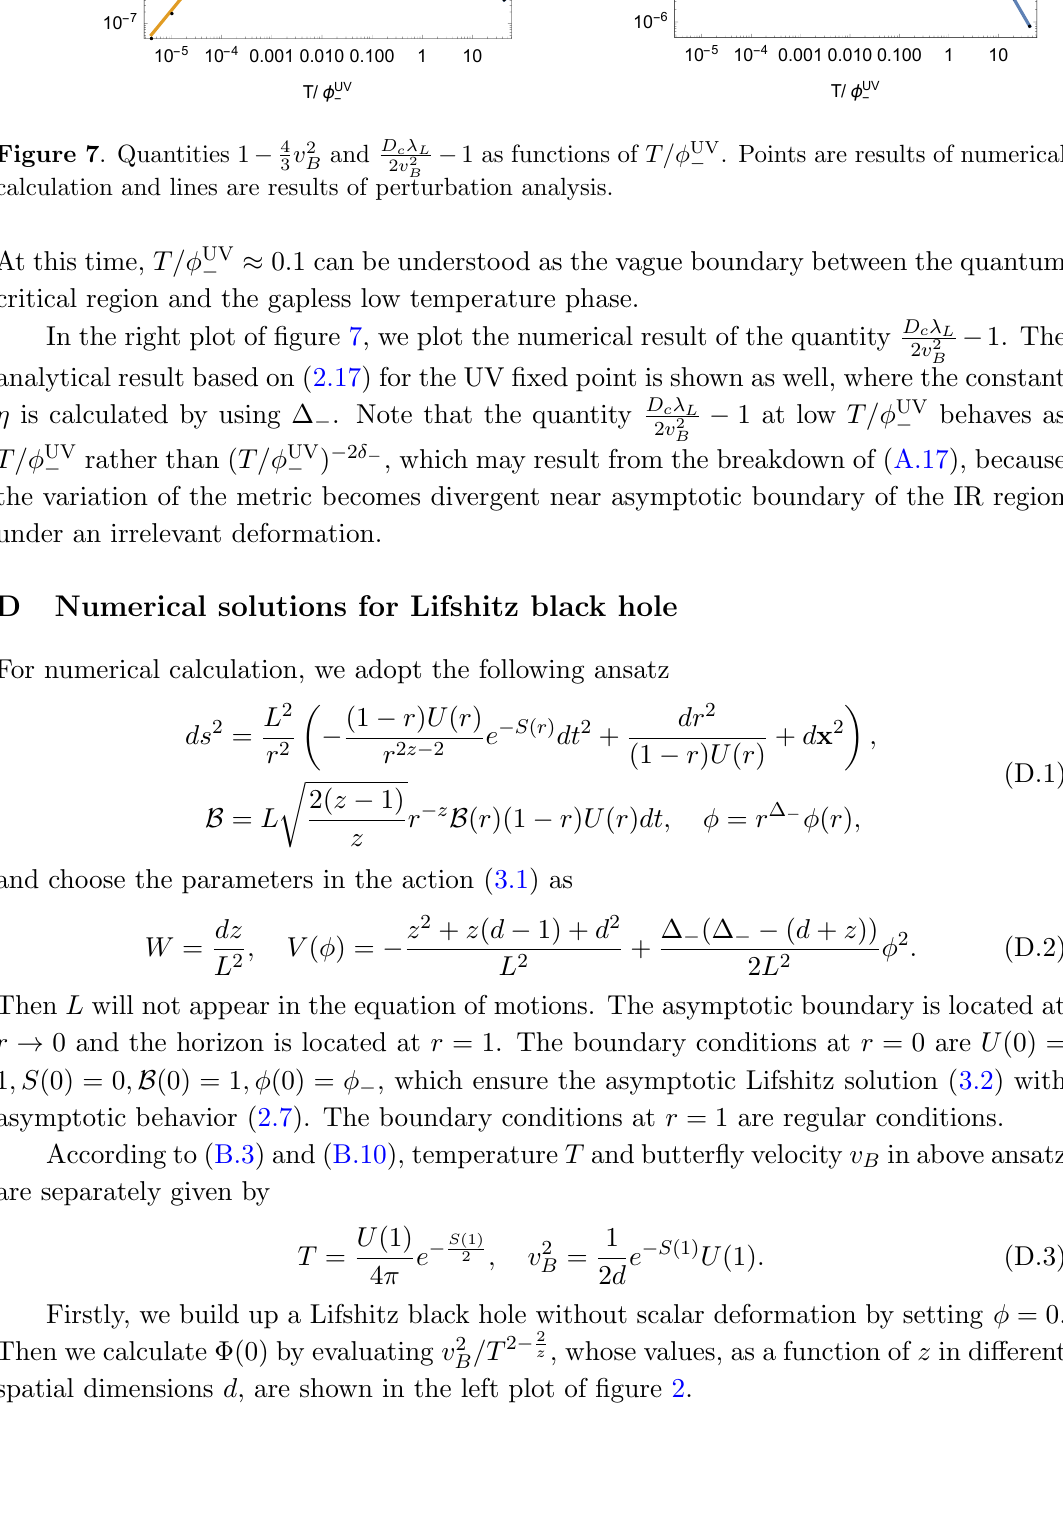
v 2 and D c (cid:21) L (cid:0) 1 as functions of T=(cid:30) UV B 3 2 v 2 B